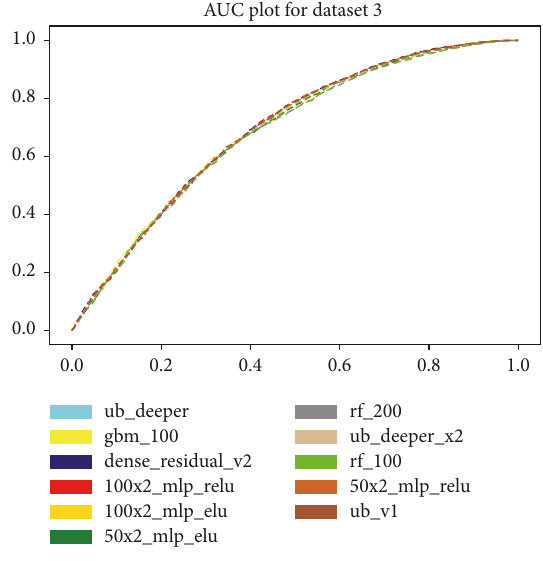
Figure 9: ROC curve for dataset 3. Table 2: Classification models and their